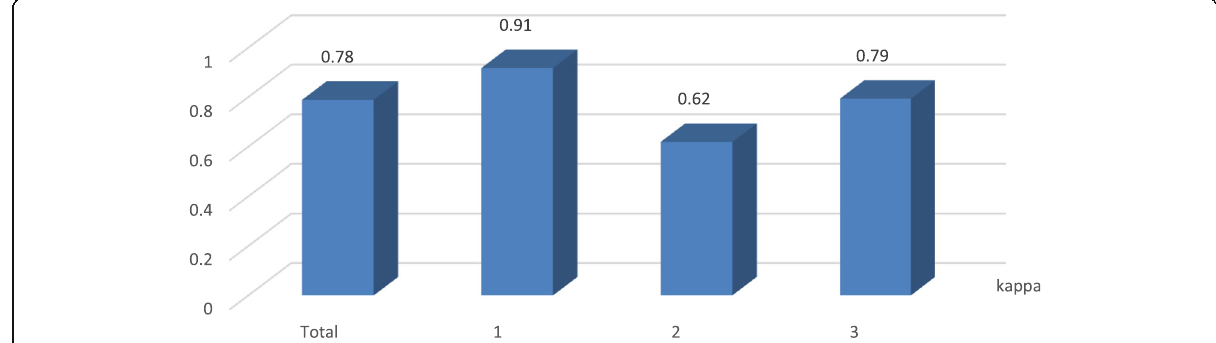
Fig. 4 Interrater reliability between the observers upon CBCT